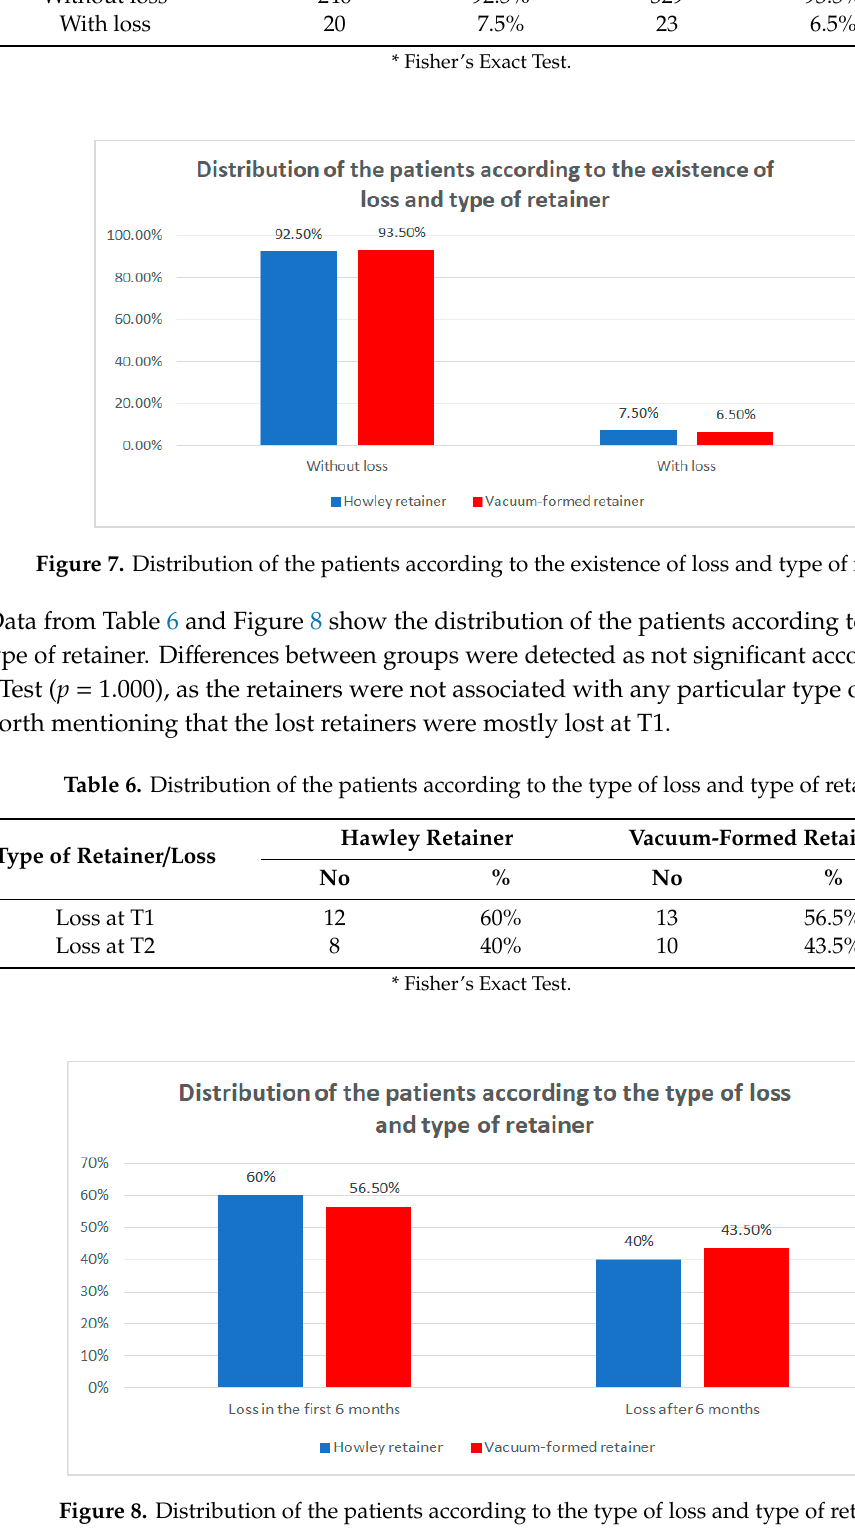
Table 5. Distribution of the patients according to the existence of loss and type of retainer. Type of Retainer/Loss